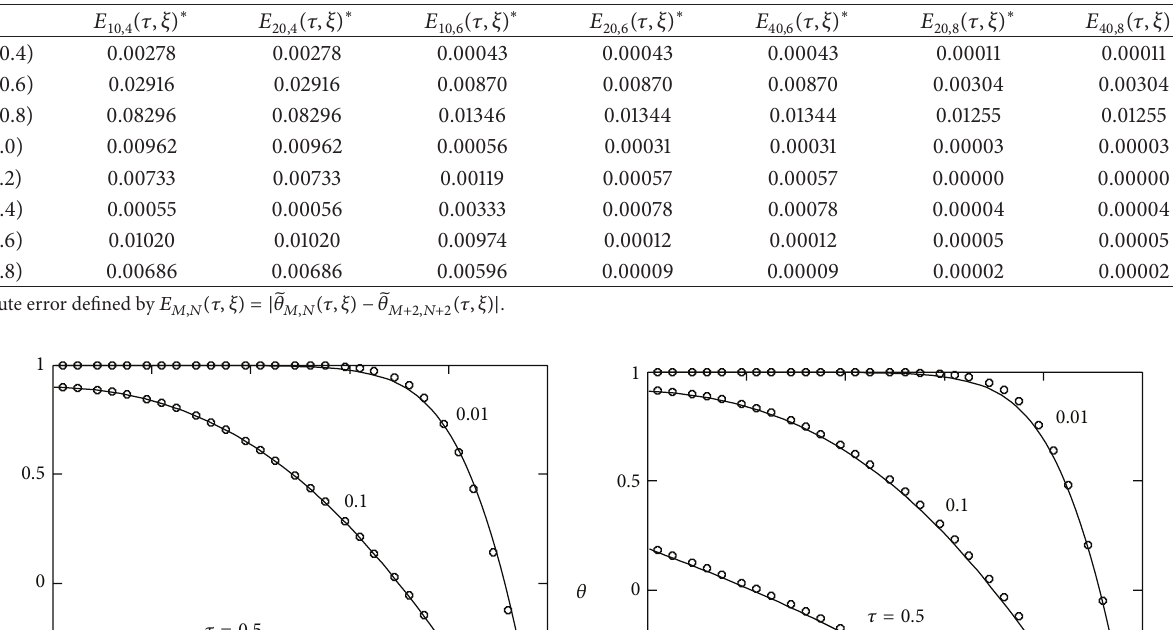
Table 2: Convergence behaviour of the series temperature solution for 𝐵 = 0 .